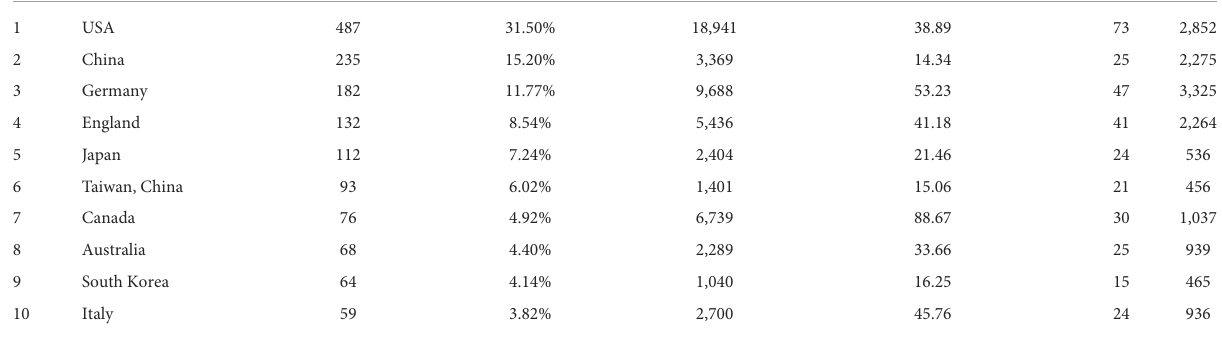
TABLE 1 The top 10 countries/regions contributing to publications about post-stroke